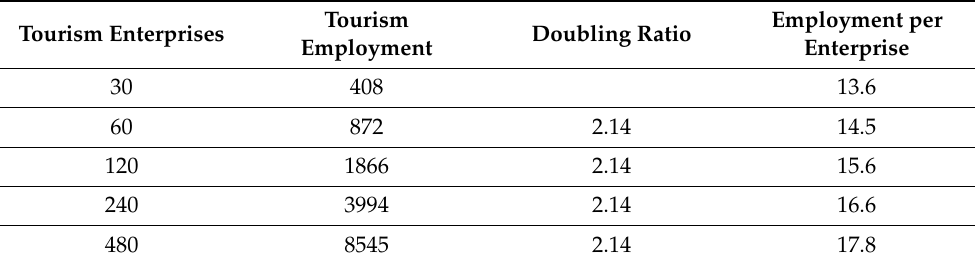
Figure 7. The power-law association between the number of tourism enterprises and tourism employment in United States micropolitans. Table 6. Tourism payrolls in relation to the number of tourism enterprises in United States micropoli- tans. The power law in Figure 7 was used in the